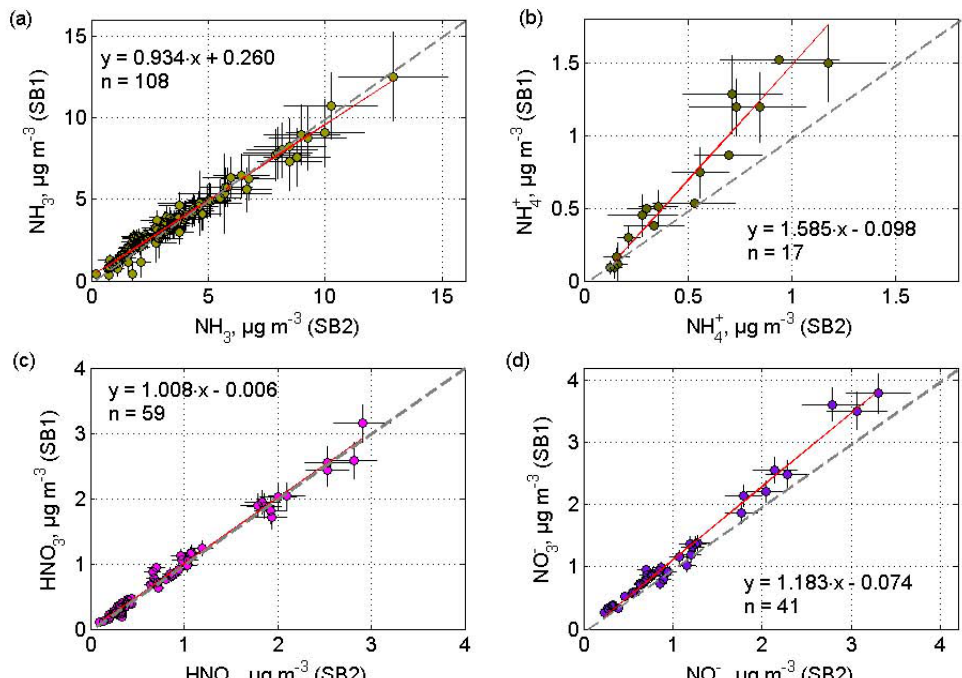
Fig. 7. Results from side-by-side measurements during the NEU experiment. The error bars indicate the random errors of the concentration measurements. Red lines and the given equations represent the individual orthogonal fits. n is the number of data points used for each fit. The dashed line indicates the 1:1 line. (SB1: sample box 1; height 0.37m; SB2: sample box 2; height 1.23m).